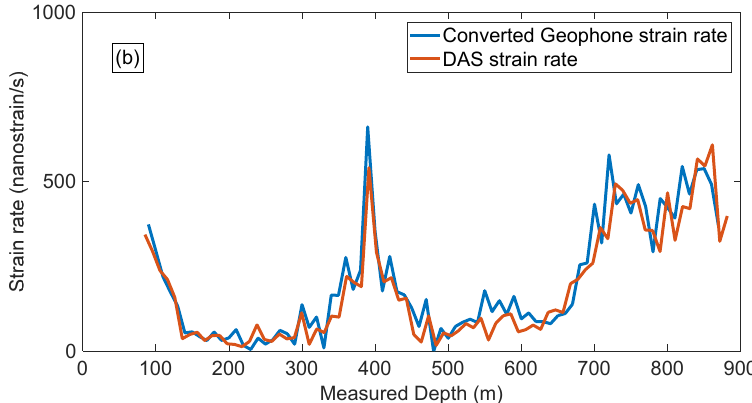
Figure 7. First-break amplitude comparison for near ( top ) and far ( bottom ) offset. The blue line is the strain rate from converted geophone, and the red line is the strain rate from DAS.